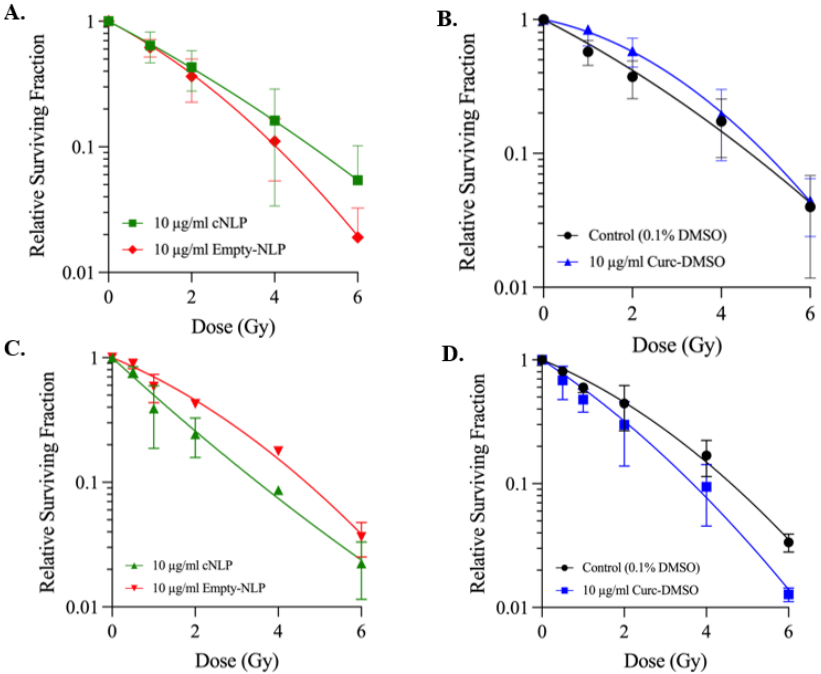
Figure 5. Curcumin NLP pre-treatment alters cell survival following 137 Cs exposures. Quiescent ( A , B ) and log-phase ( C , D ) AG05965/MRC-5 fibroblasts were pre-treated for 18 h with cNLP, curD-MSO, empty NLP, or 0.1% DMSO alone prior to 137 Cs gamma ray irradiation. Data are mean relative surviving fraction ± SD per treatment.